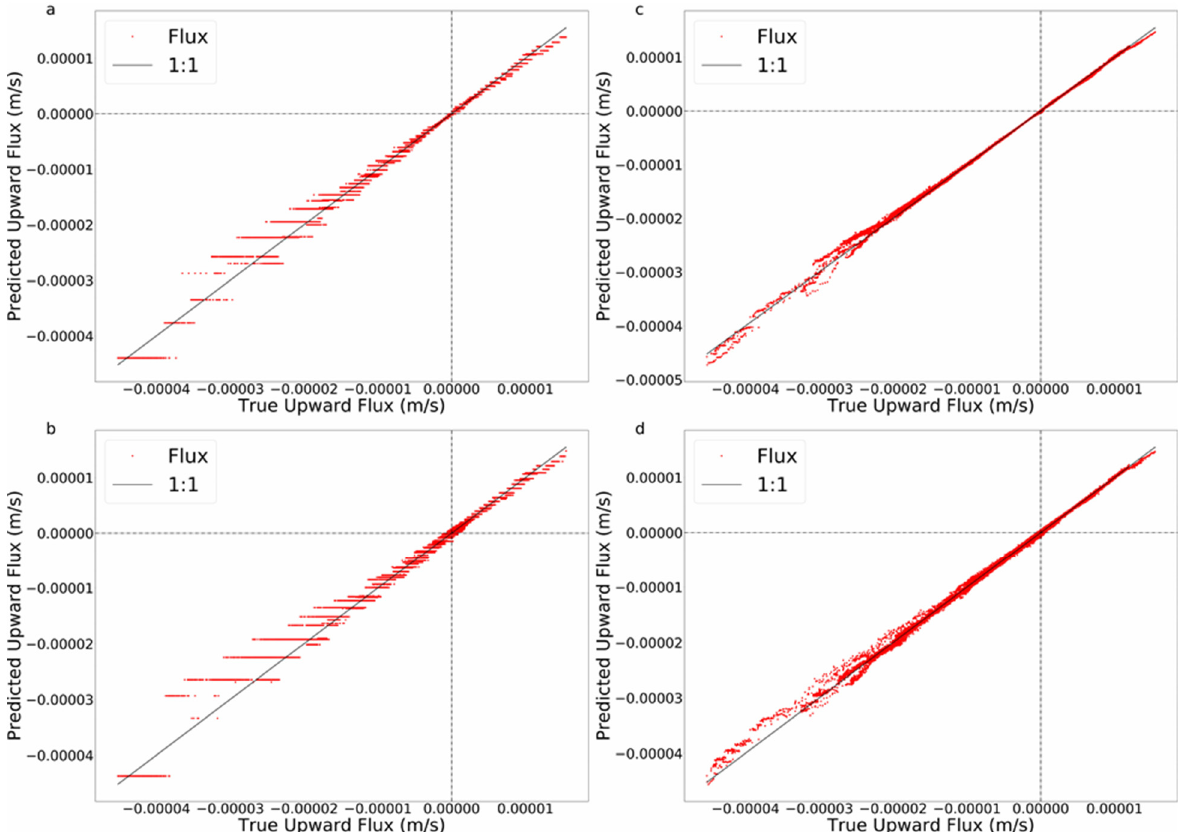
Figure 5. Testing results using temperature and pressure sensors, which are located at, 0.015, 0.105, and 0.195 m. ( a ) Noise-free data using RT. ( b ) Noise-free data using GB. ( c ) SNR = 100 noisy data using RT. ( d ) SNR = 100 noisy data using GB.